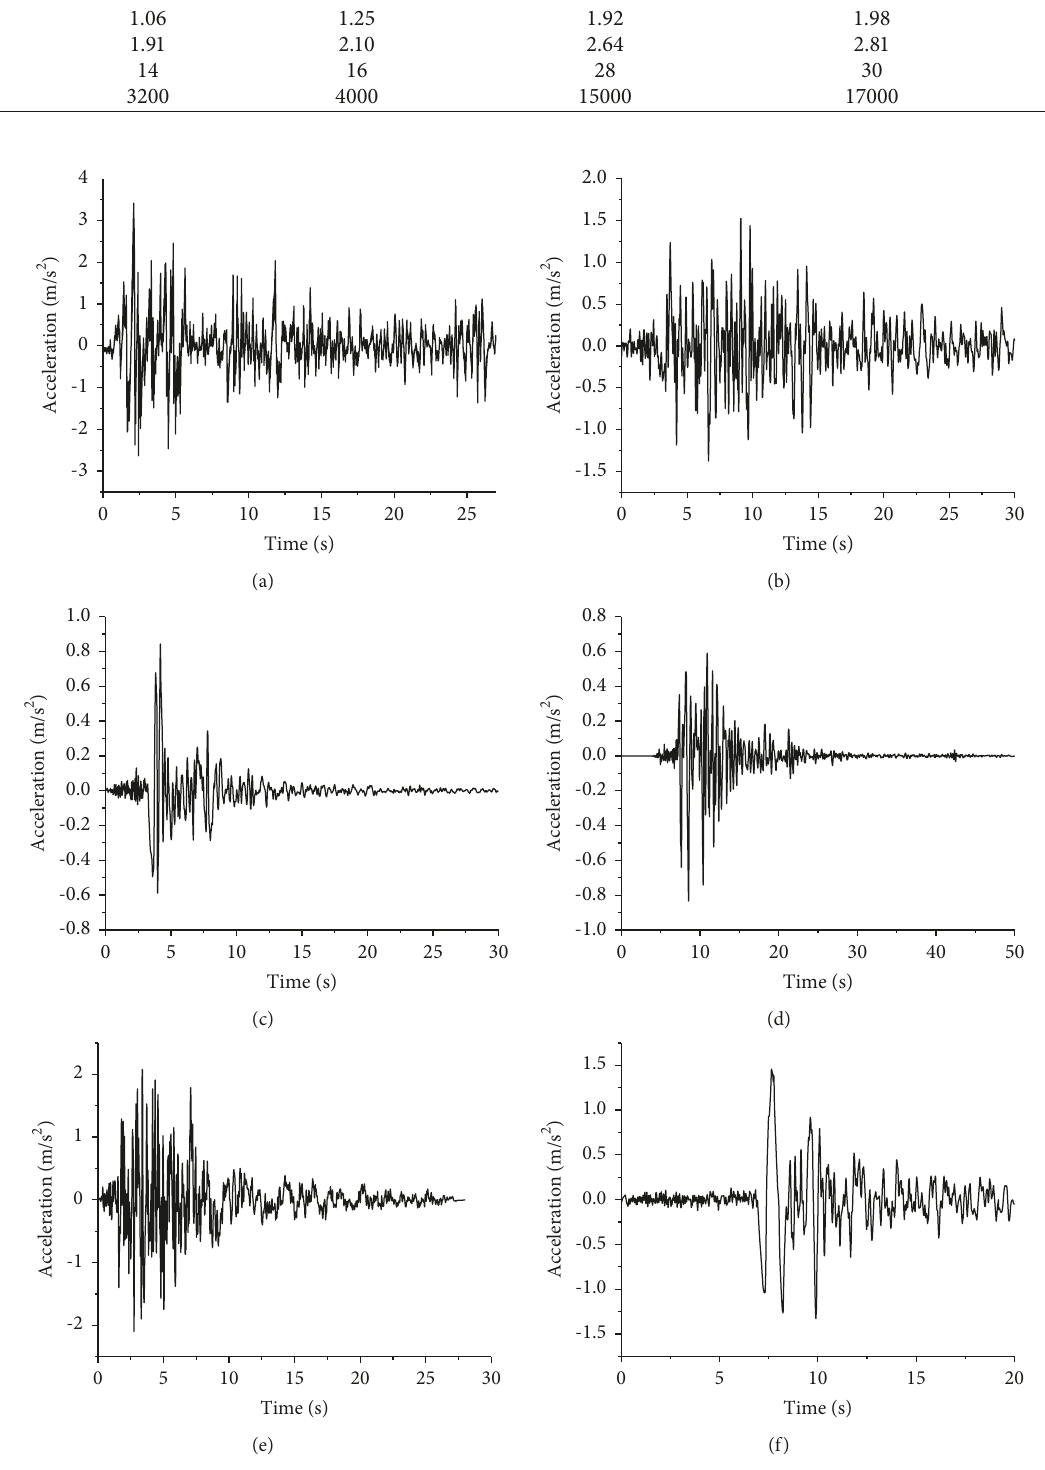
Figure 2: Acceleration time histories of input ground motions. (a) El-Centro wave. (b) Taft wave. (c) Northridge wave. (d) Kobe wave. (e) San Fernando wave. (f) Tianjin